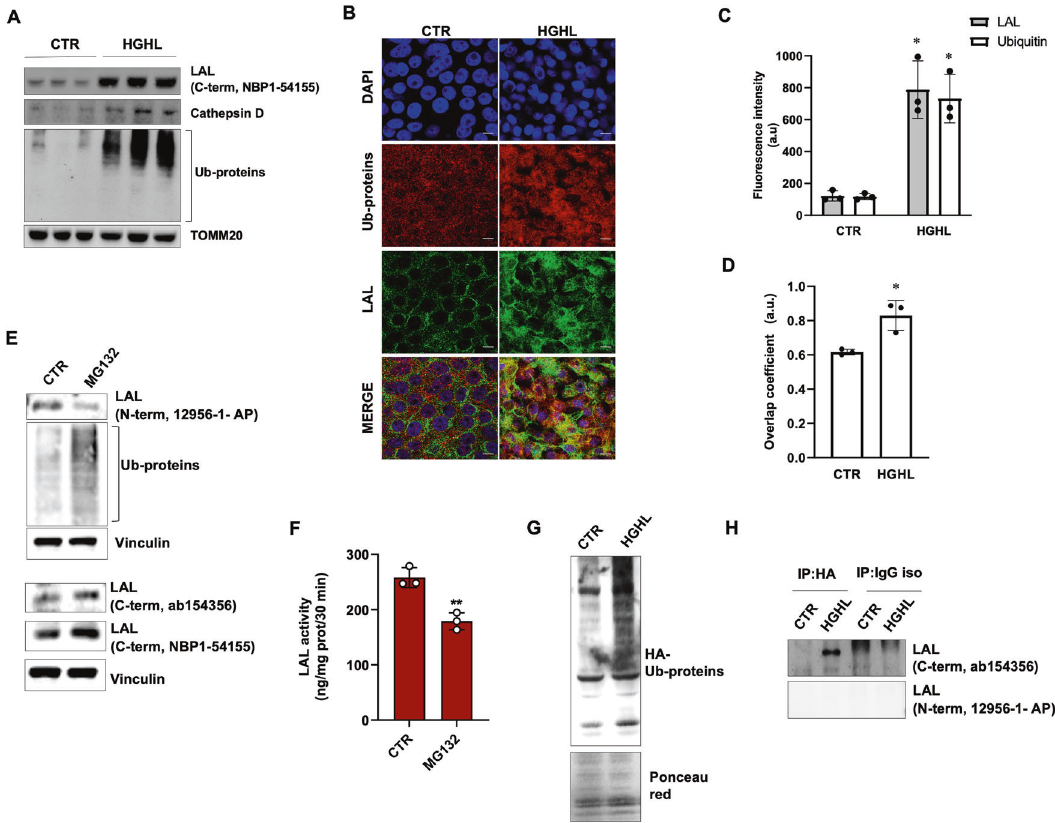
Fig. 2 LAL protein undergoes ubiquitination-mediated inactivation in an in vitro model of NAFLD. Huh7 cells were cultured in high- glucose/high-lipid (HGHL) medium for 4 ( A ) or 8 days ( B – D ) or with proteasome inhibitor MG132 (10 μ M) for 6 h ( E , F ). A Evaluation of LAL protein, ubiquitinated proteins (Ub-prot) and cathepsin D through western blot analysis. TOMM20 was used as loading control. B – D Analysis of LAL ubiquitination by confocal microscopy. Ubiquitinated proteins (red) and total LAL protein (individuated by antibody against C-term) (green) were shown ( B ), and their abundance ( C ) and colocalization ( D ) were evaluated. E Evaluation of LAL (by different anti-LAL antibodies against C-term or N-term) and ubiquitinated proteins (Ub-prot). Vinculin was used as loading control. F LAL activity determined by spectrophotometric enzymatic assay. G Representative western blot of Huh7 cells expressing HA-tagged ubiquitin. Anti-HA antibody was used to reveal ubiquitinated proteins under 4 days HGHL treatment. Ponceau red staining was used as loading control. H Western blot analysis of LAL by using C-term or N-term antibody on immunoprecipitated HA-ubiquitinated proteins under 4 days HGHL treatment. Immunoblots are representative of one experiment out of three giving similar results. Data are expressed as mean ± SD (* p < 0.05, ** p < 0.01, vs CTR; n = 3). Scale bar 25 μ